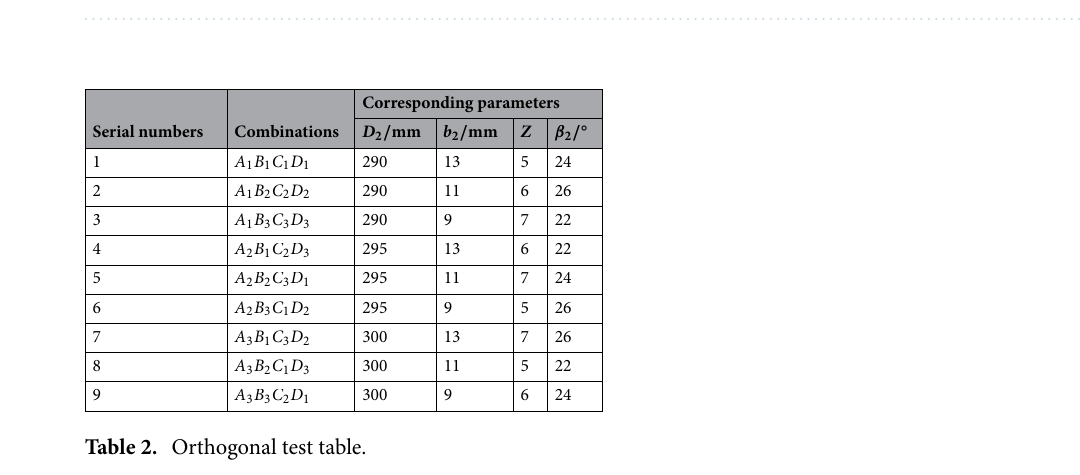
Table 1. Factor level table.